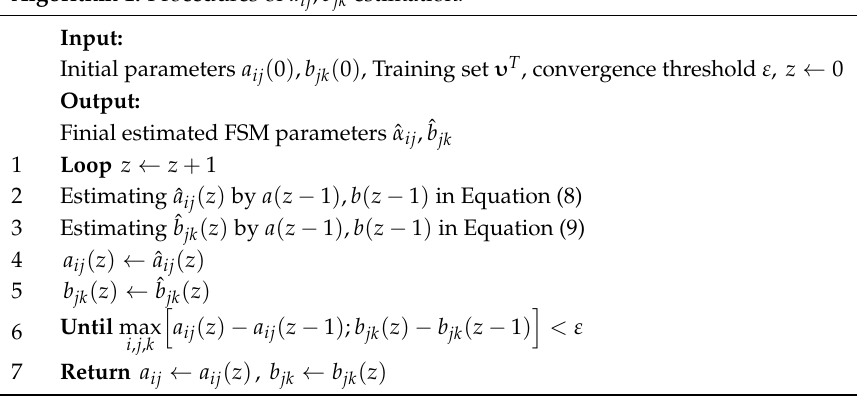
Algorithm 1. Procedures of a ij , b jk